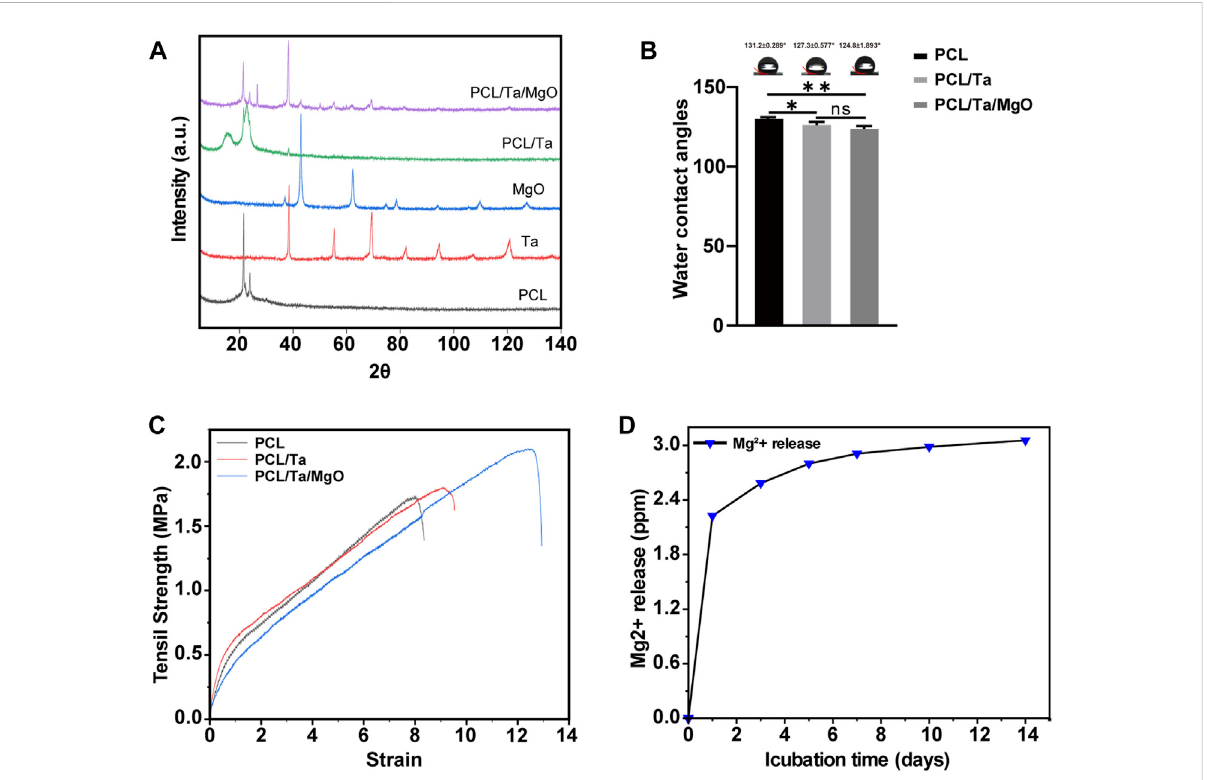
FIGURE 2 (A) XRD diffraction of PCL, tantalum nanoparticles, magnesium oxide nanoparticles, and nanocomposite membranes. (B) Water contact angles of PCL, PCL/Ta, and PCL/Ta/MgO membranes. Compared to pure PCL, PCL/Ta and PCL/Ta/MgO showed decreased contact angles ( n = 3). (C) Representative stress – strain curves of the nanocomposite membranes. (D) Magnesium ion release from the PCL/Ta/MgO membrane. (* p < 0.05, ** p < 0.01, *** p < 0.001, and **** p <